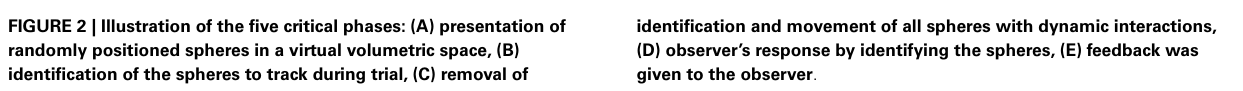
identification and movement of all spheres with dynamic interactions, (D) observer’s response by identifying the spheres, (E) feedback was given to the observer